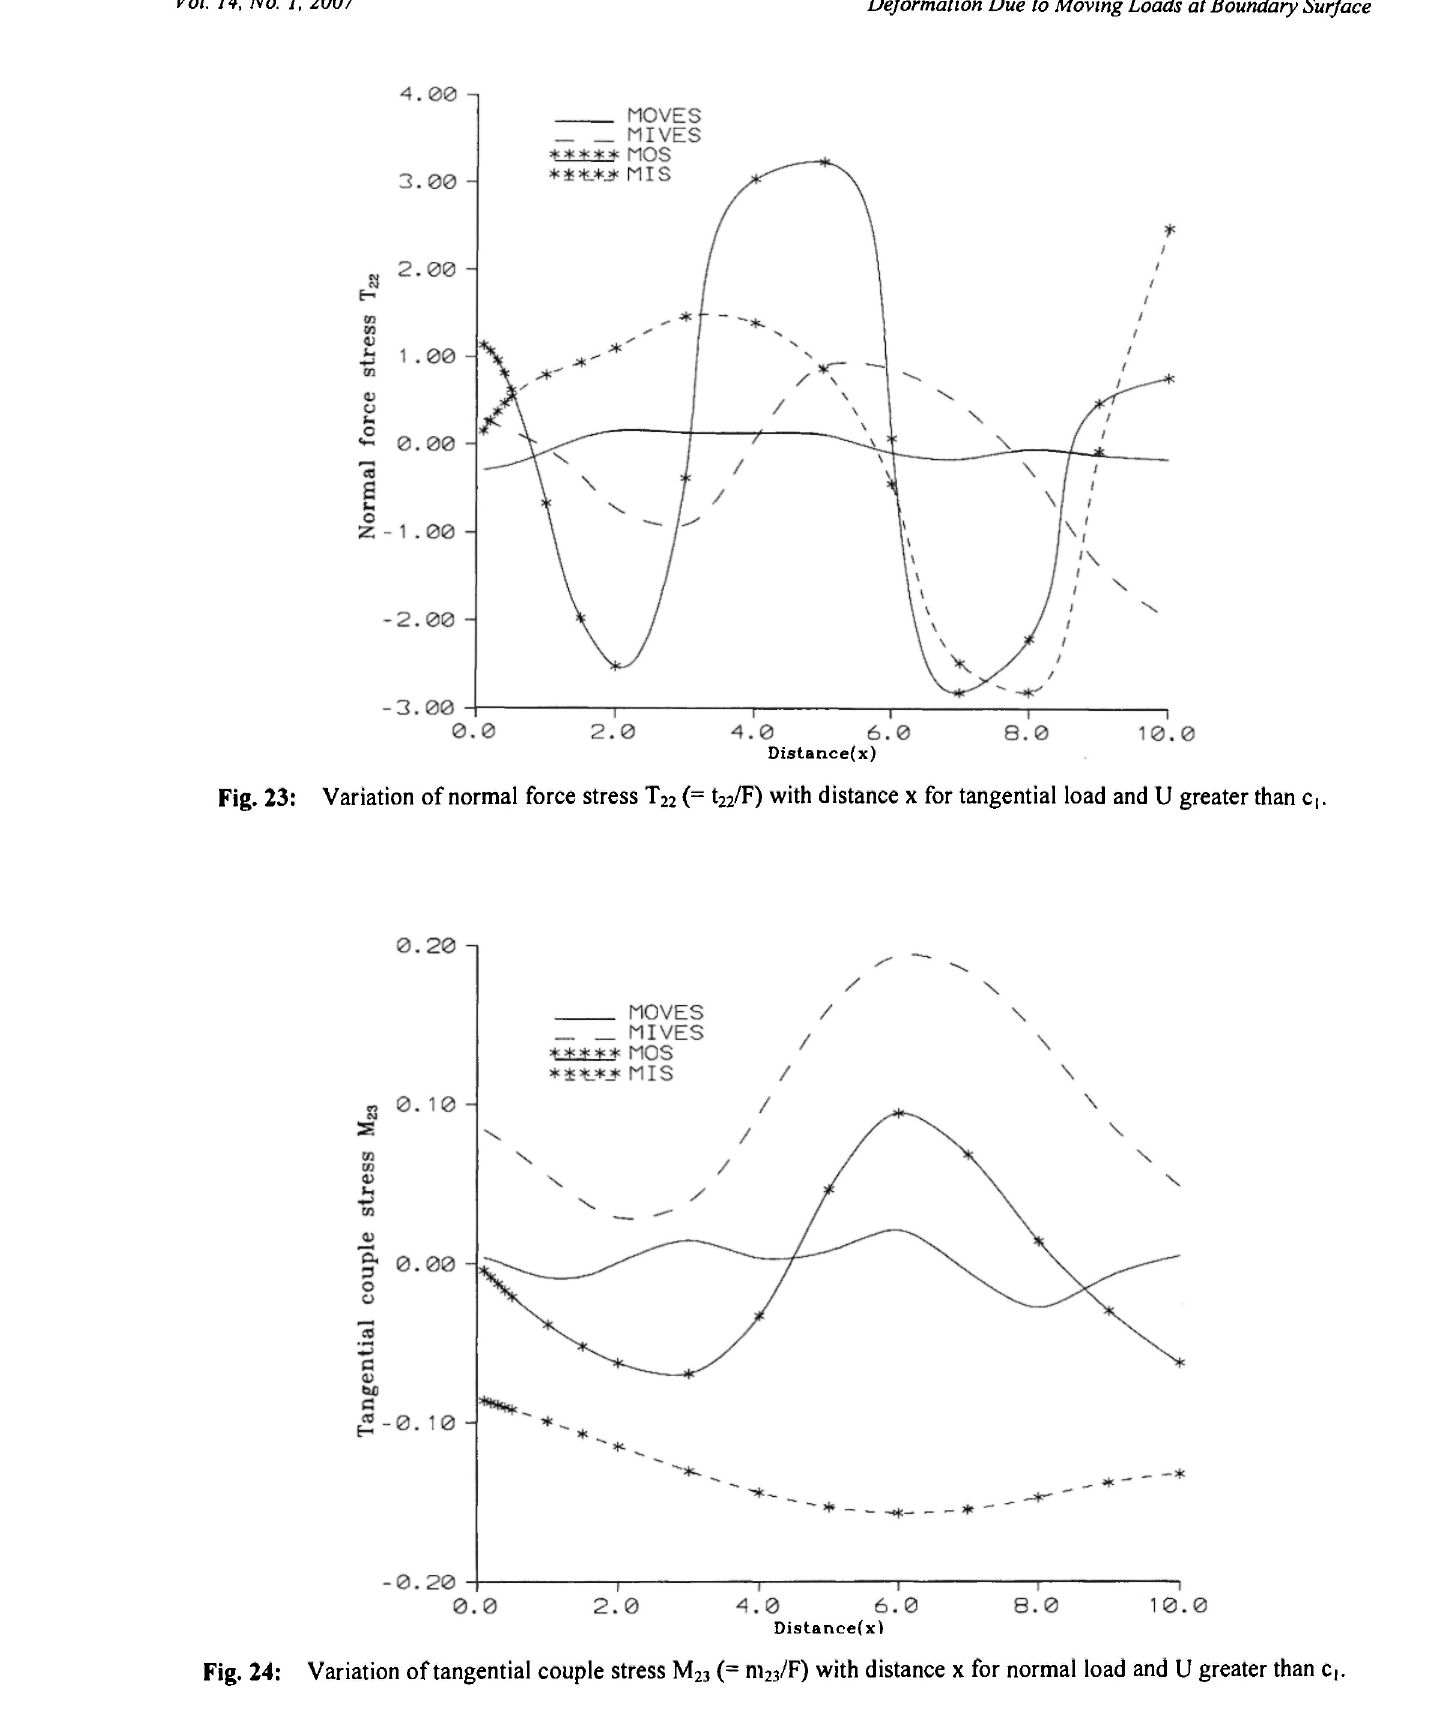
Fig. 24: Variation of tangential couple stress M 2 3 (= nWF) with distance χ for normal load and U greater than